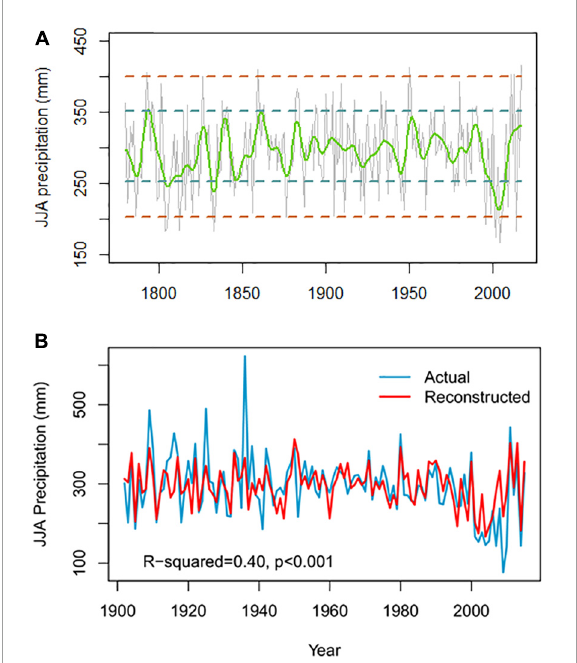
FIGURE5 Reconstruction of PPT JJA in Darma, valley, Western Himalaya; (A) the reconstructed June–August (JJA) precipitation (Grey line plot) for the period 1780–2017. Dotted blue and orange line plots indicate m ± SD and m ± 2 SD of the reconstructed data. The green smoothed line indicates a 10-year low-pass filter and (B) time series of observed (blue line plot) and reconstructed (red line plot)